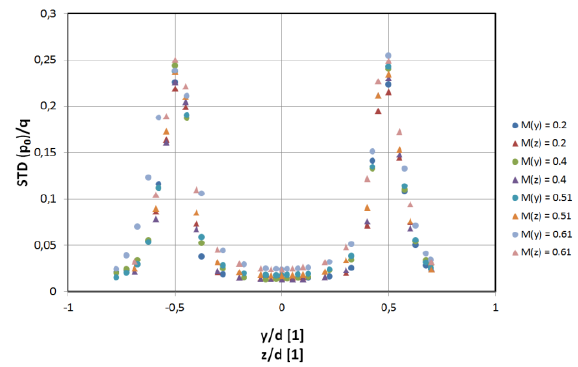
Fig. 7. Distribution of STD( p 0 )/ q detected by FRAP probe in centerline at distance x/d e = 1.0.